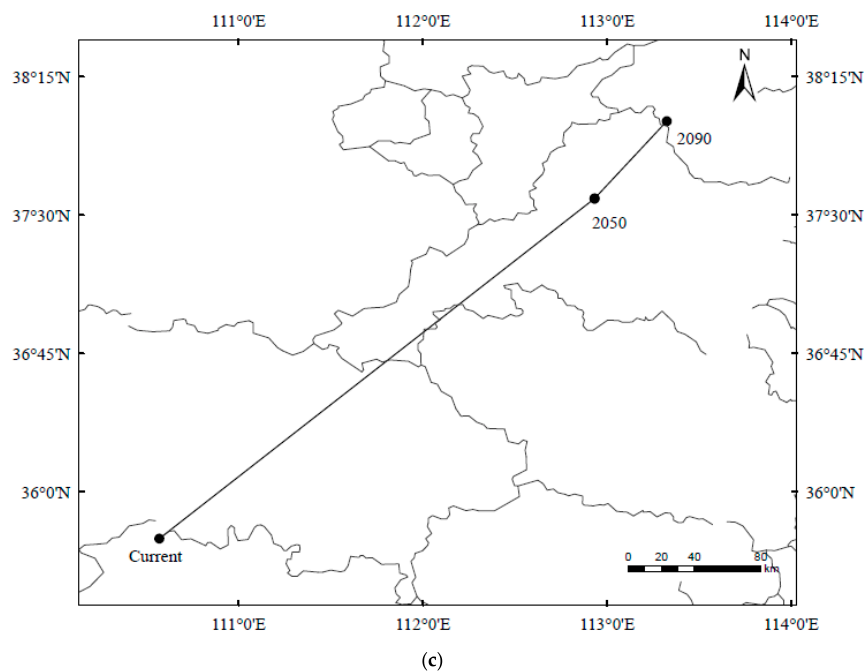
Figure 5. Spatial transfer characteristics of Anoplophora glabripennis in ( a ) current–2050 and ( b ) 2050–2090 stages and ( c ) centroid transfer trajectory in China.